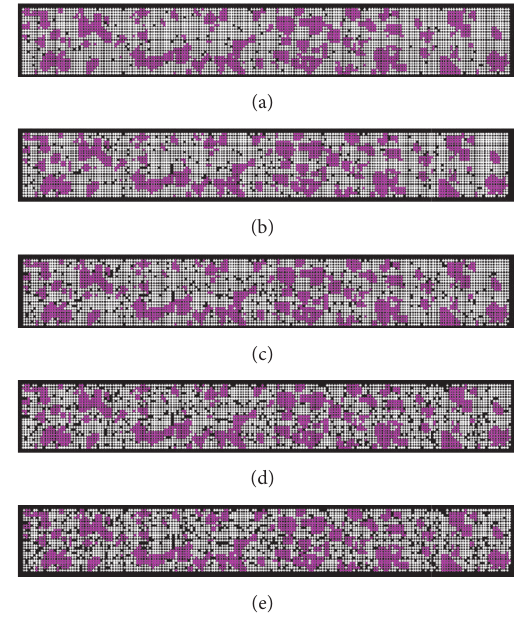
Figure 7: Cross sections of virtual sample with different air